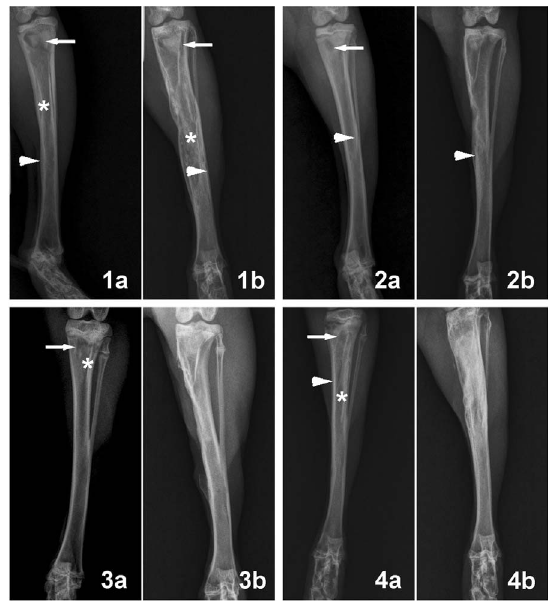
Figure 6. Blood analysis of animals implanted with cements. (a) Boron concentration in the serum of rabbits implanted with vancomy- cin-loaded borate BG cement as a function of time post-surgery; (b) vancomycin concentration in the serum of rabbits implanted with borate BG cement and CS cement as a function of time post-surgery.